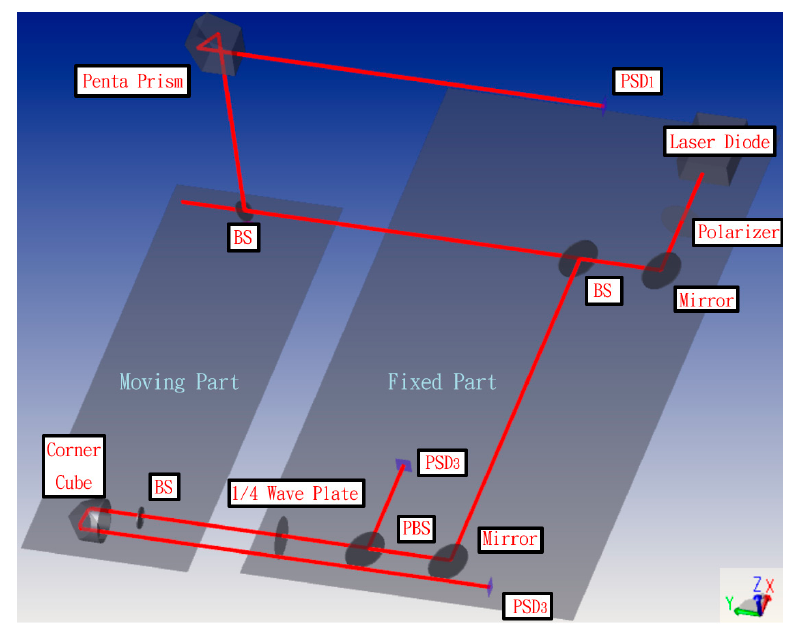
Figure 6. Zemax 3D optical model of the proposed measurement system.